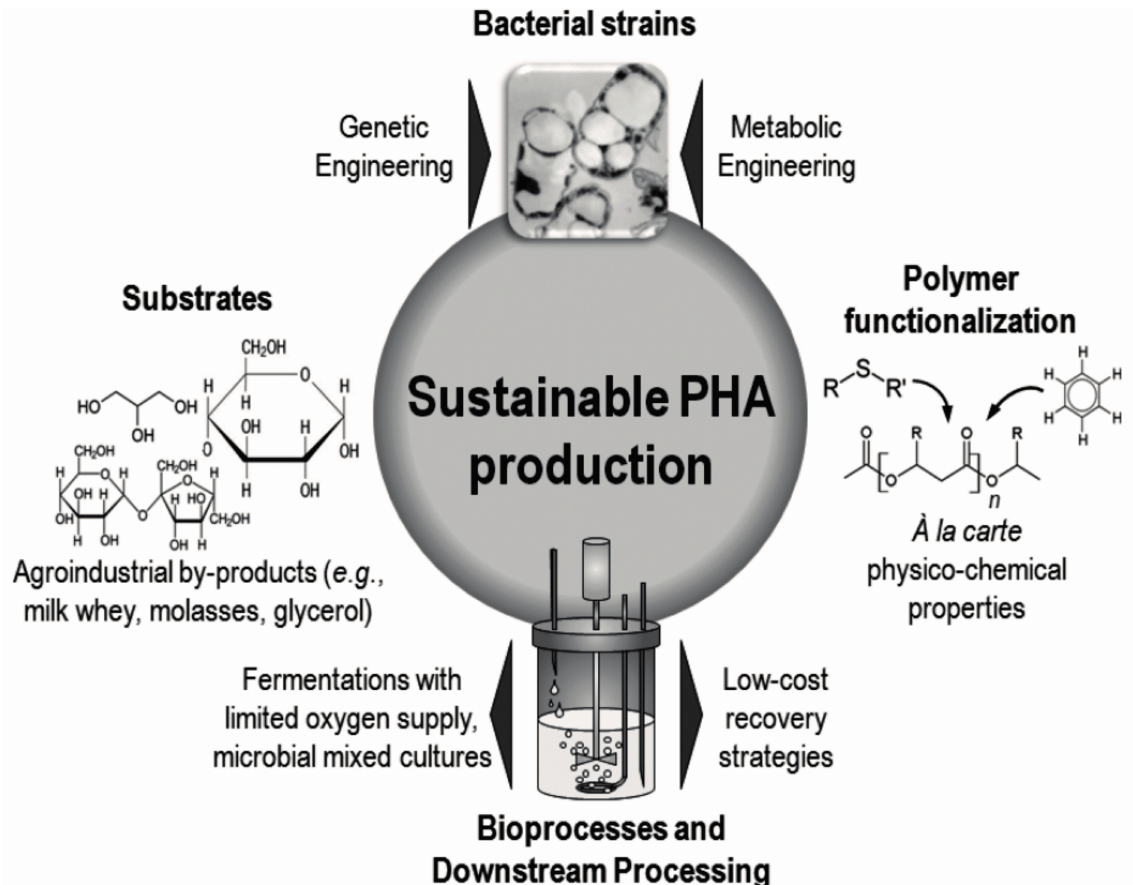
Figure 4. Strategies used to enhance the sustainability of polyhydroxyalkanoates (PHA) production processes, originally published in [21] under CC BY 3.0